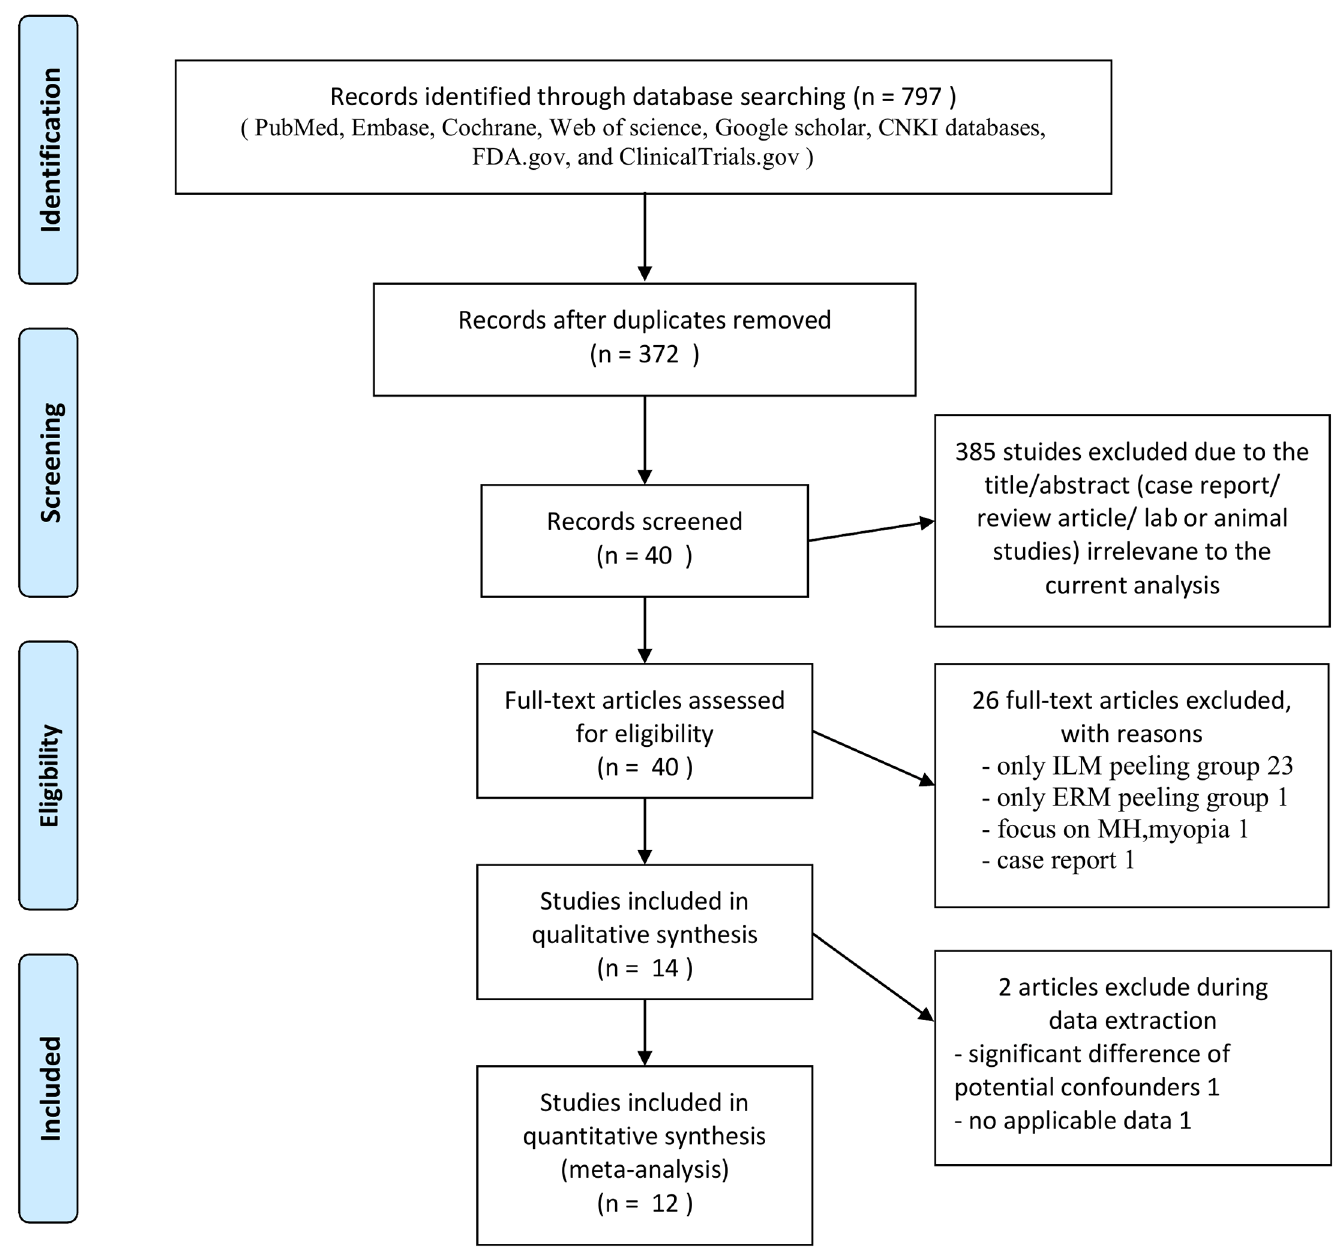
Fig 1. Flow diagram of the process of identifying eligible